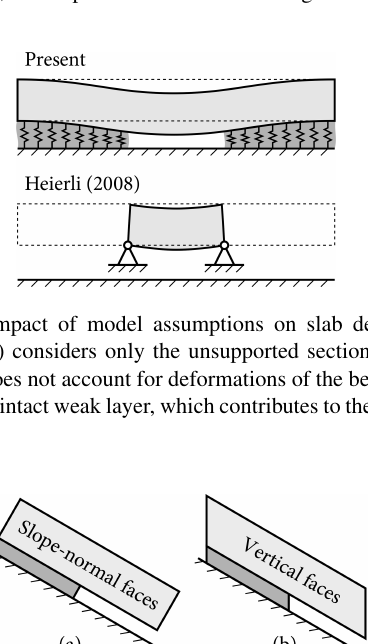
Figure 11. Energy release rate G in propagation saw tests (PSTs) in flat terrain. Comparison of the present model (blue lines), Heierli (2008) model (red line) and FEA results (gray circles). Both models agree well with FEA data for short crack lengths and stiff (i.e., thin) weak layers. The model by Heierli (2008) cannot reproduce varying weak-layer properties and provides a lower bound of the energy re- lease rate corresponding to vanishing weak-layer thickness. Except for h = 30cm, model parameters are chosen as given in Fig. 1.